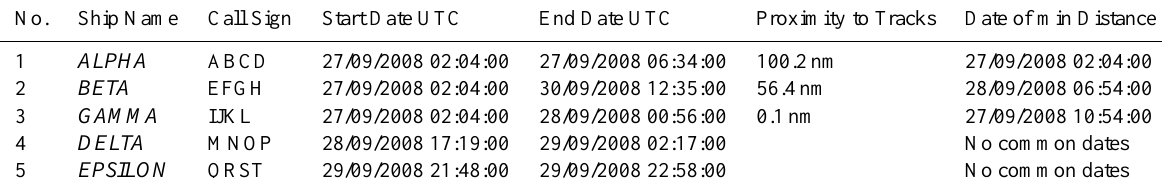
Table 1. List of the ships together with a computation of their nearest approach to the slick track. No.